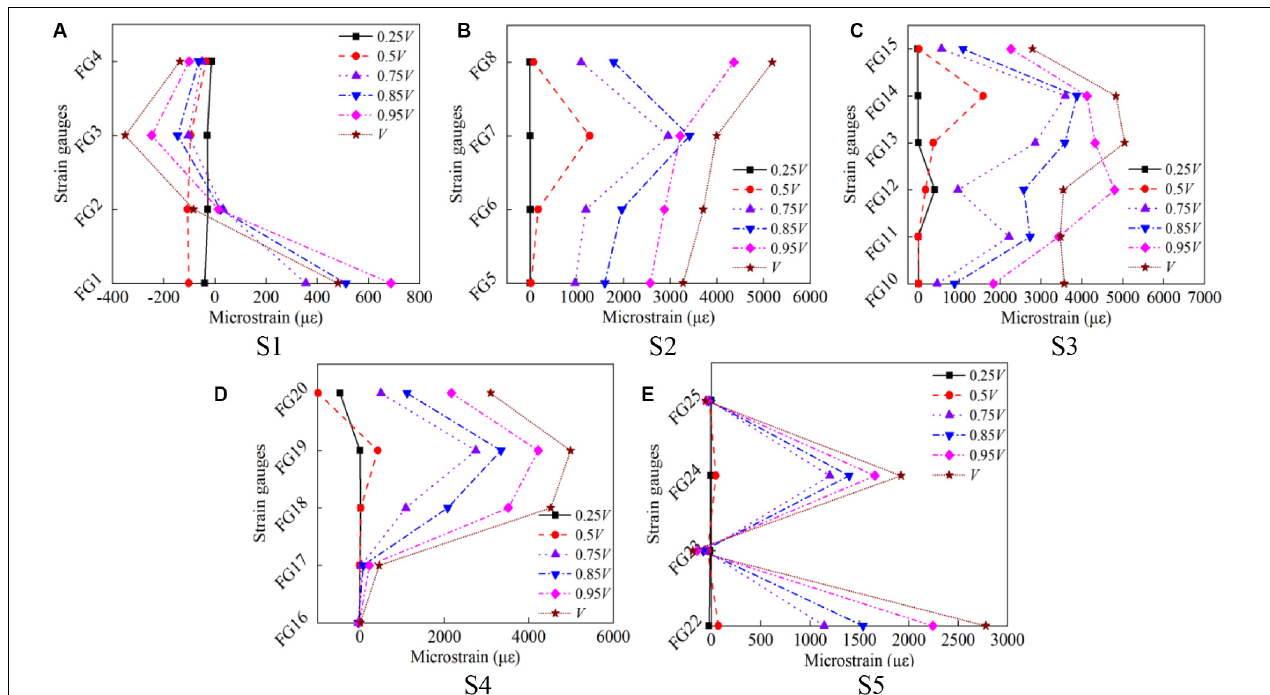
FIGURE 12 | Strain distribution along the height of CFRP strips for EB-1-0. (A) S1, (B) S2, (C) S3, (D) S4, and (E) S5.